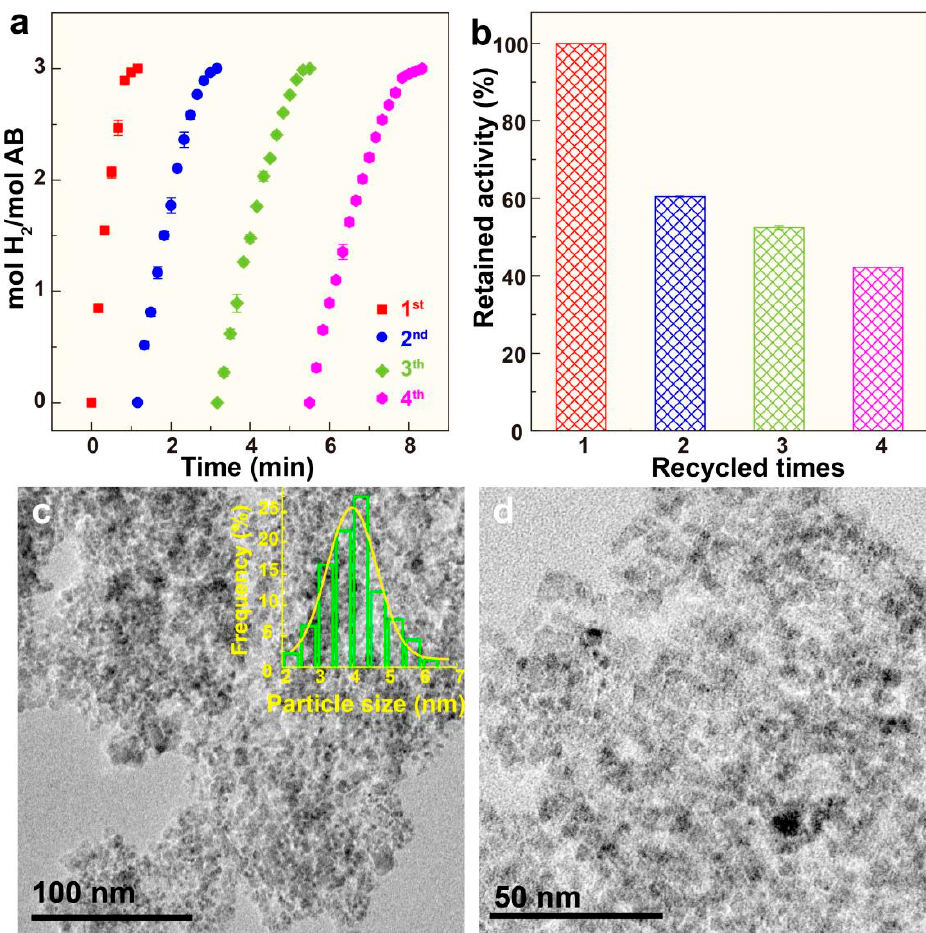
Figure 4. ( a ) Plots of hydrogen generation for different recycling runs; ( b ) the retained activity of each cycle; ( c , d ) TEM images of recycled catalyst (inset is corresponding size distribution).